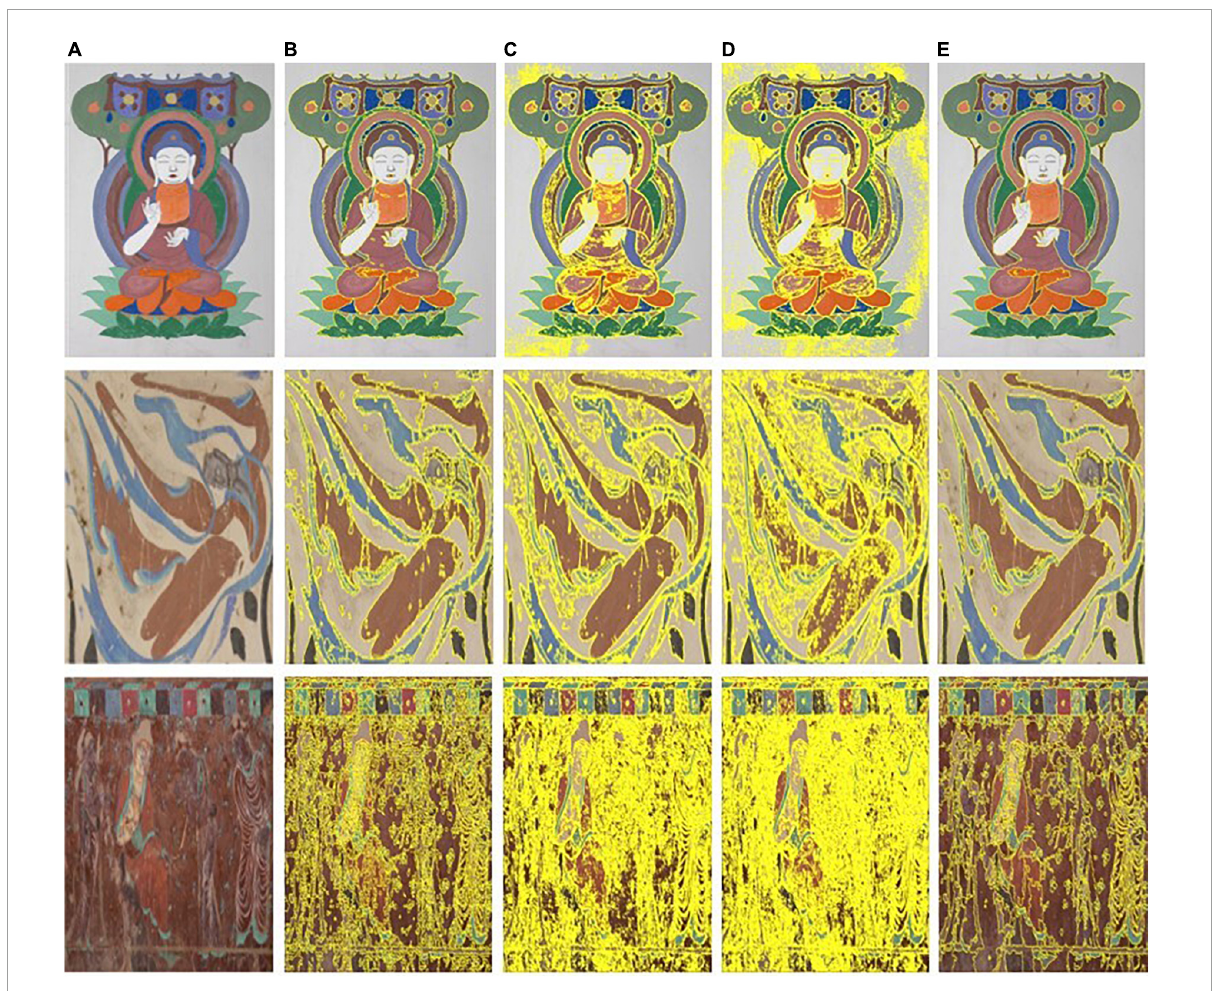
FIGURE4 Test images and segmenting results of the different segmenting methods. (A) Test image. (B) Kovesi. (C) Dasgupta. (D) Yan. (E) Proposed.